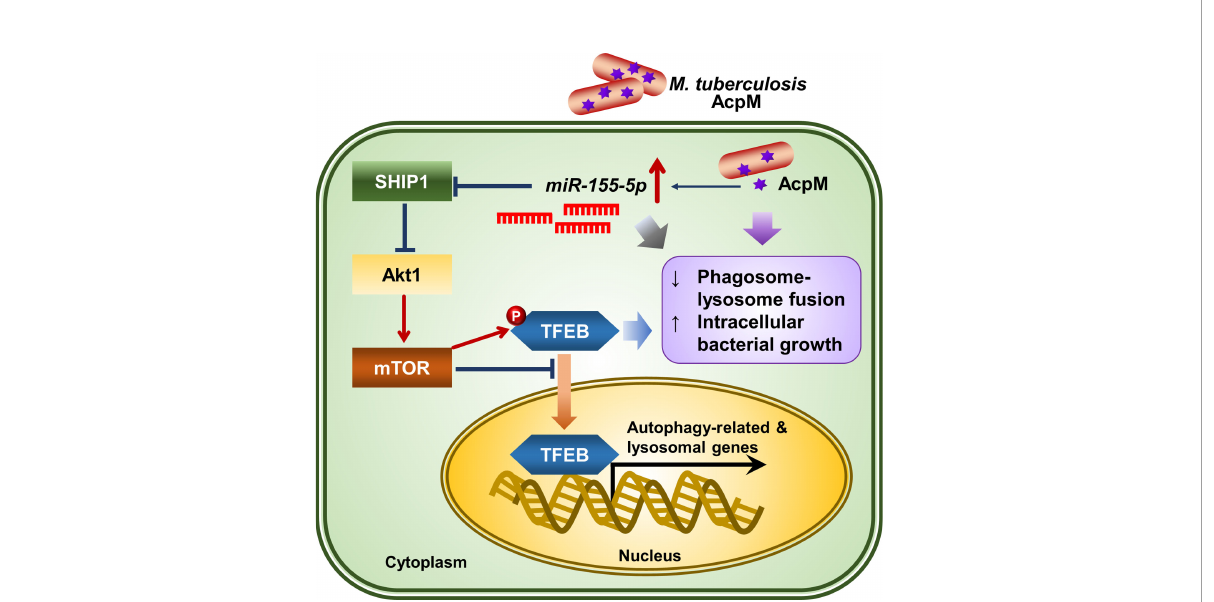
FIGURE 8 The proposed mechanism of action of AcpM in Mtb-infected macrophages. AcpM promotes the expression of miR-155, which targets SHIP1 to activate the Akt/mTOR pathway. The activated Akt/mTOR signaling pathway inhibits TFEB nuclear translocation and reduces the expression of autophagy and lysosomal genes, which is likely to induce antimicrobial defense in macrophages. AcpM also improves intracellular mycobacterial survival by inhibiting phagosome-lysosome